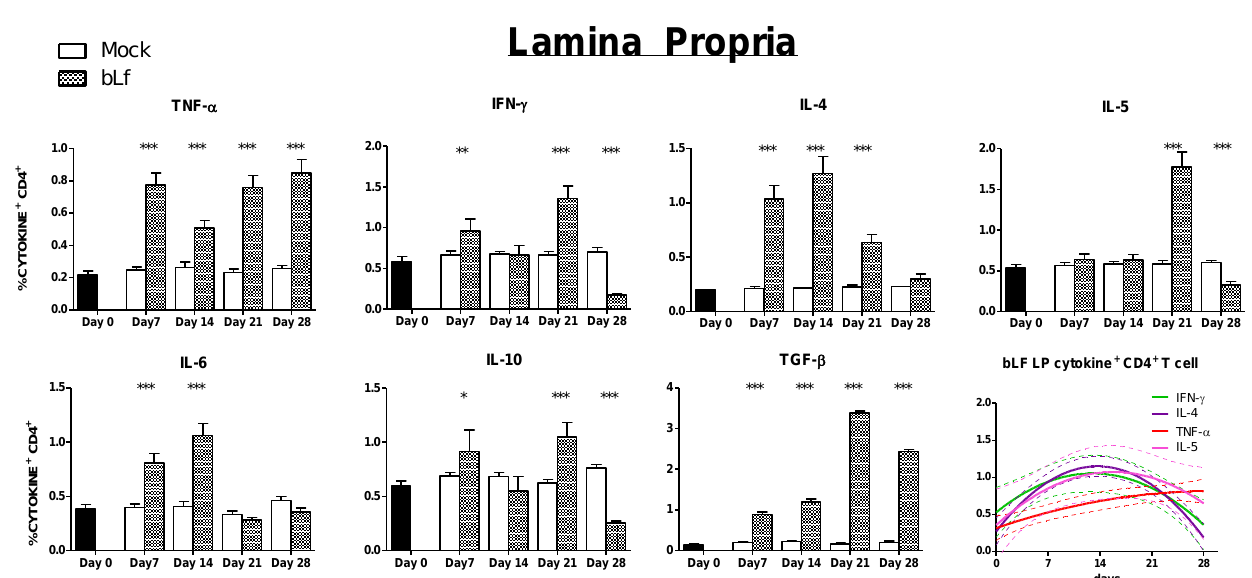
Figure 4. Effects of oral bLf vs. mock on the percentages of cytokine+ CD4+ T cells in LP of the proximal small intestine. Mean and SD are shown. Non-linear regression models were plotted for TNF- α , IFN- γ , IL-4 and IL-5. Significant differences: * p ≤ 0.05, ** p ≤ 0.01, *** p ≤ 0.001 compared to mock. Non-significant results are omitted.